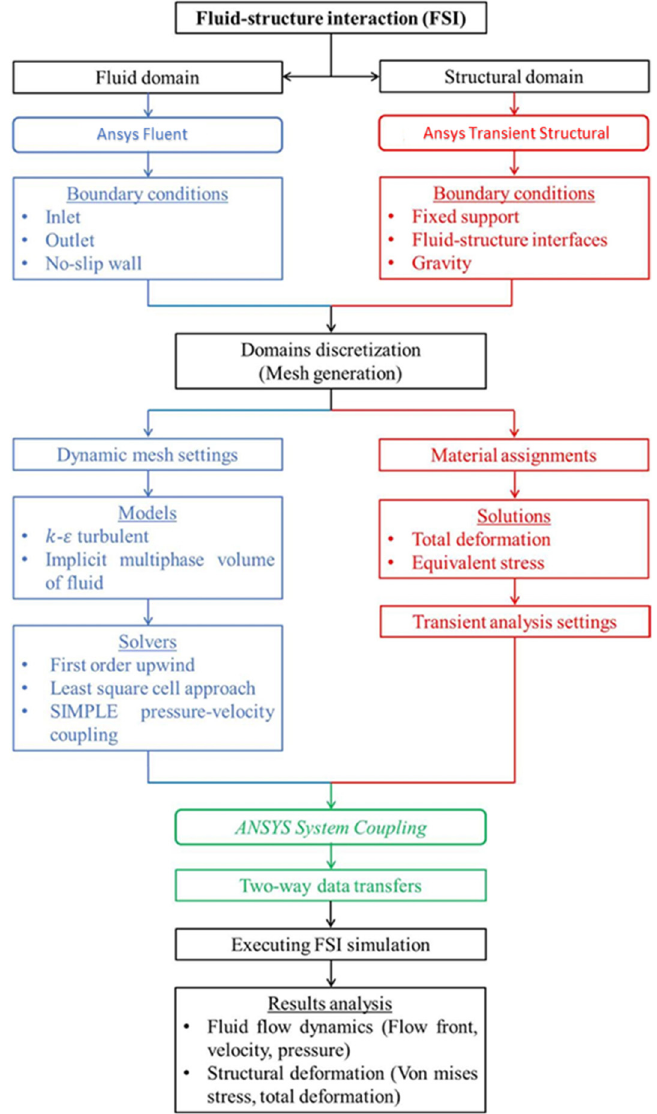
Figure 5. Flow sequences of the fluid–structure interaction numerical simulation.